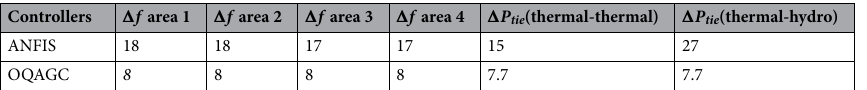
Table 6. Comparative study of settling time 56 . The designed Optimal Quadratic Automatic Generation Controller settling time values are in italics.